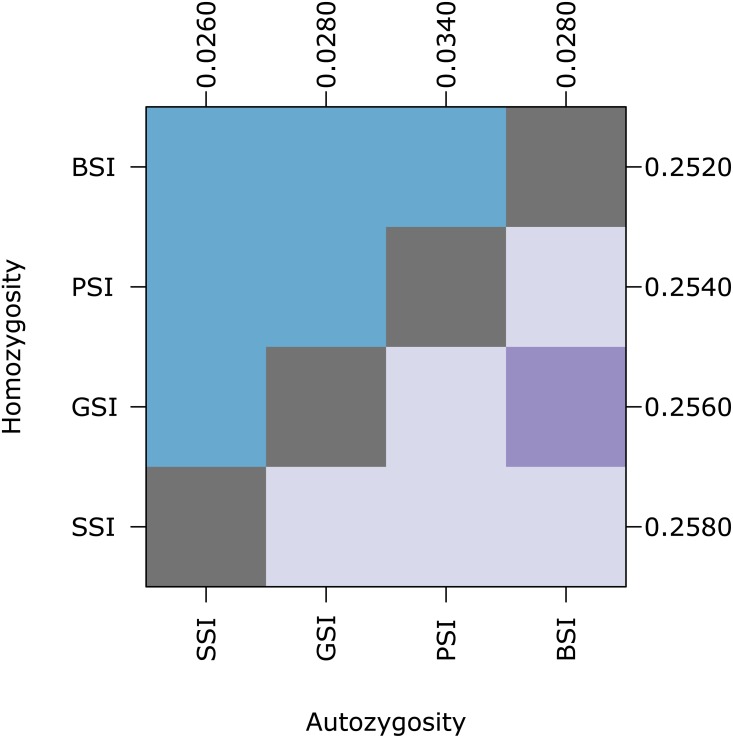
Biparental inbreeding avoidance is fairly stable with respect to S allele diversity.The plot shows pairwise comparisons for simulations of each SI system in which the number of S alleles were reduced to 10 under the k-alleles mutation model. The upper (blue) and lower (purple) triangles compare the distribution of proportions of homozygotes and autozygotes, respectively, in 500 samples from each simulation. The color of each square indicates the outcome of a Holm-corrected, pairwise Anderson–Darling test which determined whether the pair of distributions were significantly different (p < 0.05; light color) or not (dark color). The values along the right and top axes are the medians for homozygosity and autozygosity, respectively. The simulations are sorted on both axes by median homozygosity. The simulations included inbreeding depression and were run on a 100 ×100 landscape with σ = 1 for the pollen and seed dispersal parameters.